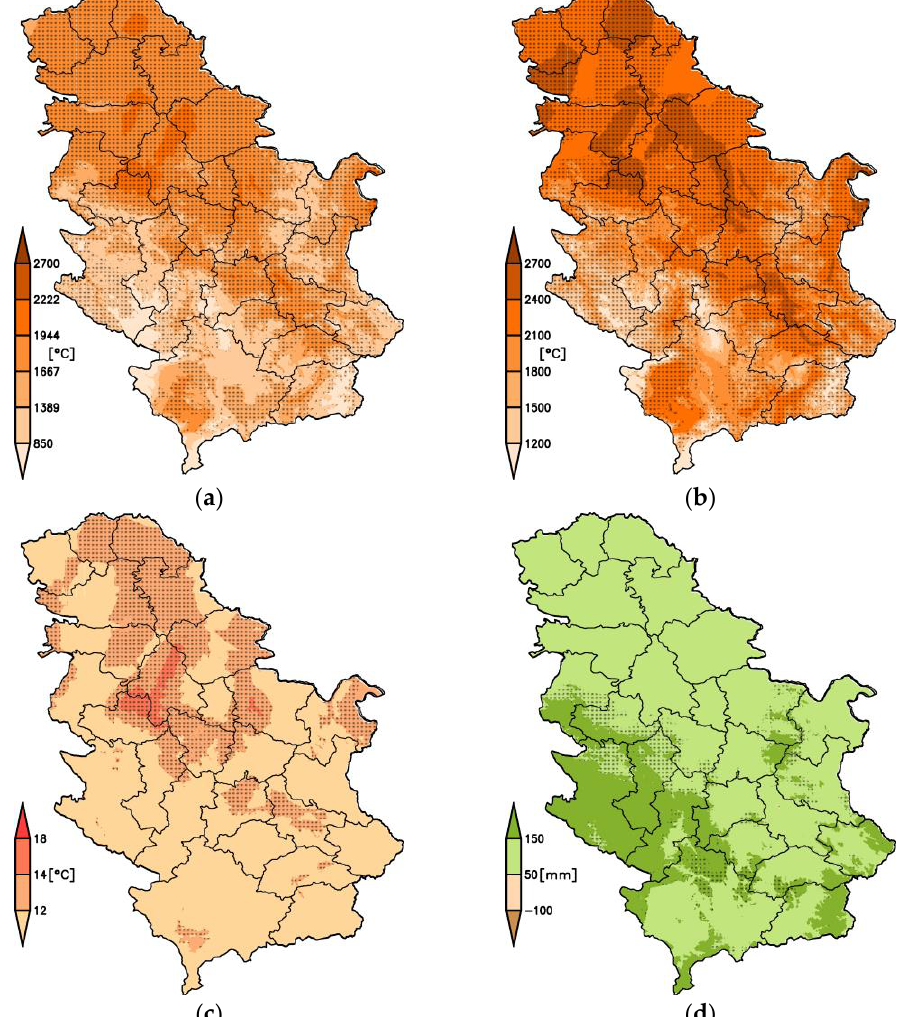
Figure 4. Winkler index ( a ), Huglin index ( b ), Cool Nights index ( c ), and Dryness index ( d ) categories for the period 1998 – 2017. Black dots mark areas where the index category has changed in comparison to 1961 – 1990.